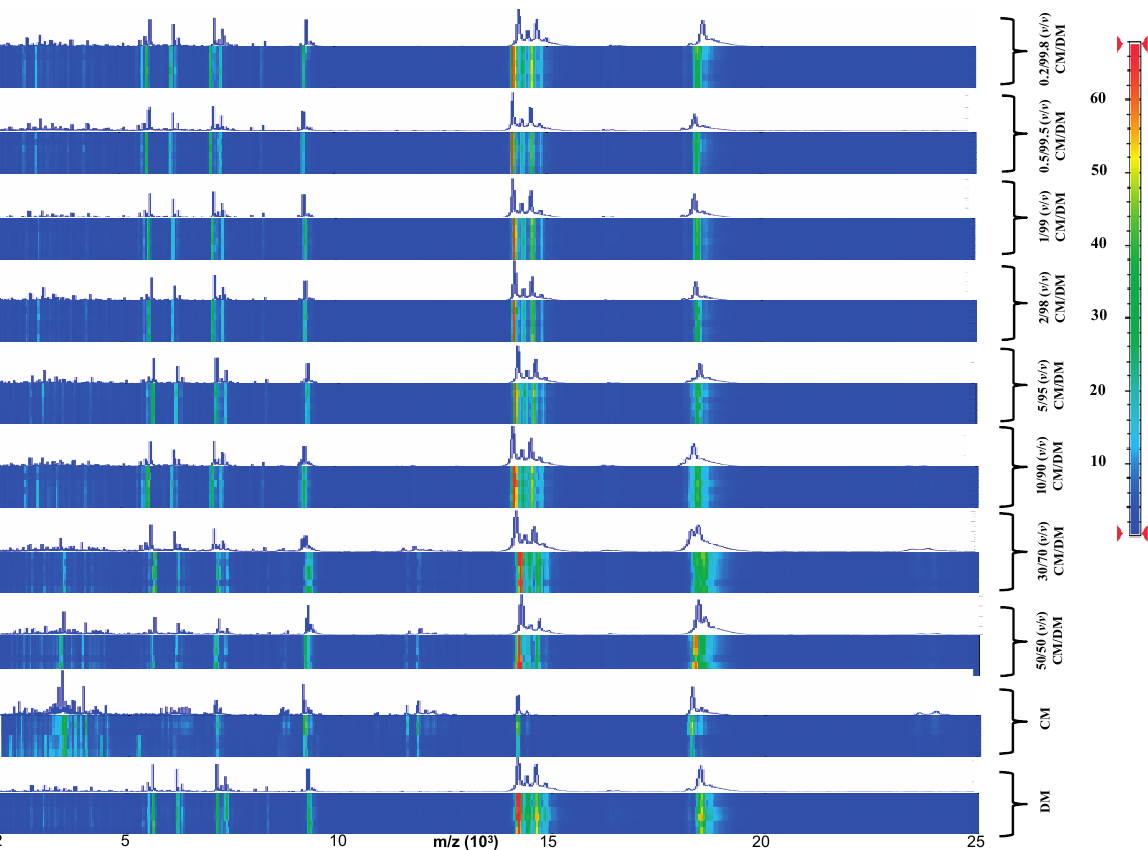
Figure 3. Pseudo-gel like image and MALDI-TOF MS spectra of the simulated adulteration of DM by CM.